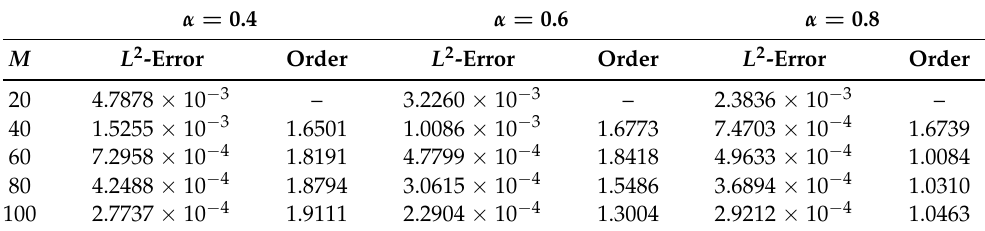
Table 2. The L 2 -norm errors and temporal convergence orders for Example 1 using scheme (18),